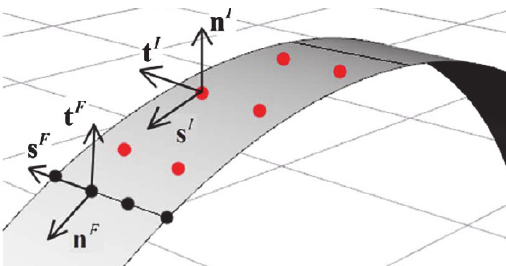
Figure 5: FRP-masonry interface and local reference system.